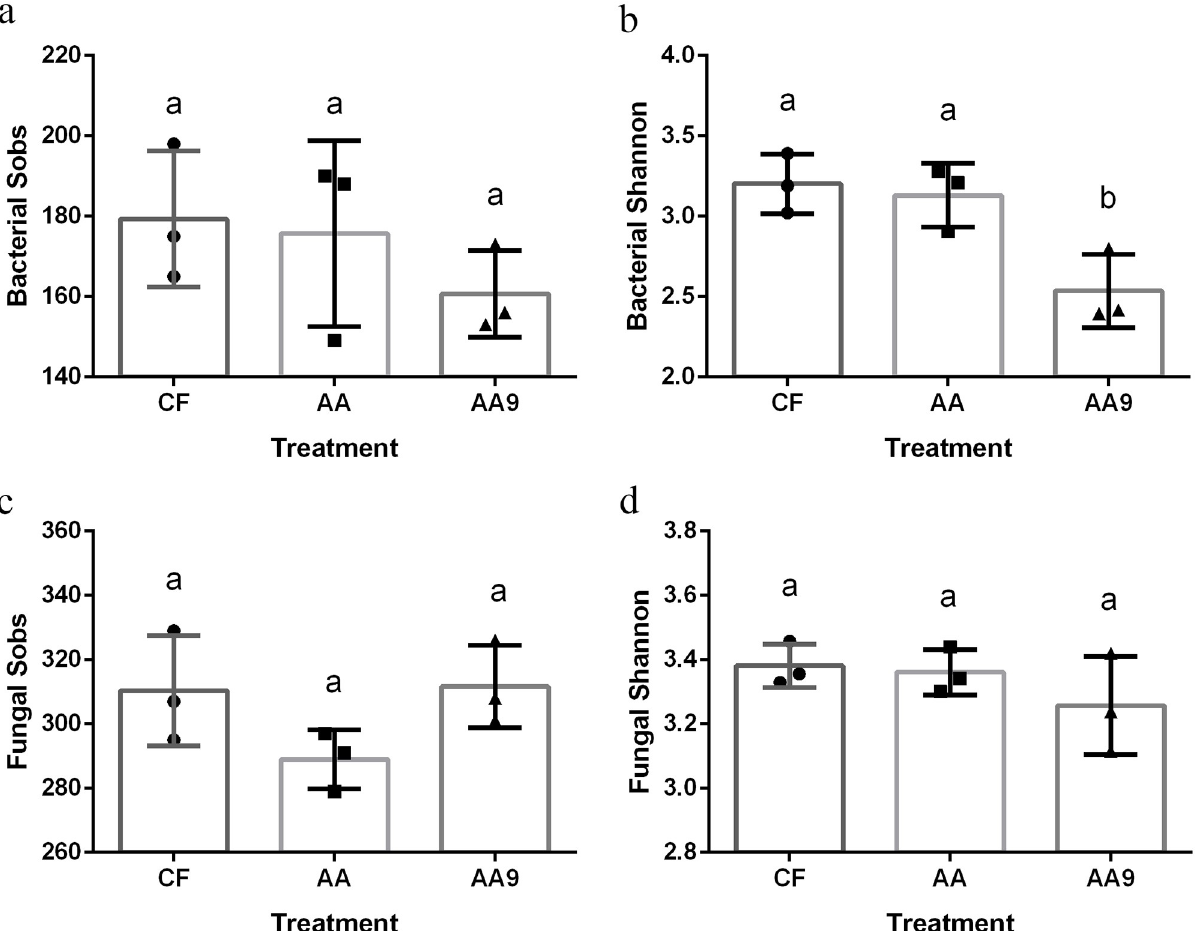
Fig 2. Bacterial and fungal α diversity. Bacterial and fungal richness (Sobs) and diversity (Shannon) indices in different treatments corresponding to different fertilization treatments. CF, treatment sprayed with chemical fertilizer; AA, treatment sprayed with amino acids liquid fertilizer; AA9, treatment sprayed with liquid biological fertilizer. Different letters in the same line indicate significant differences as defined by Duncan’s test ( P < 0.05).